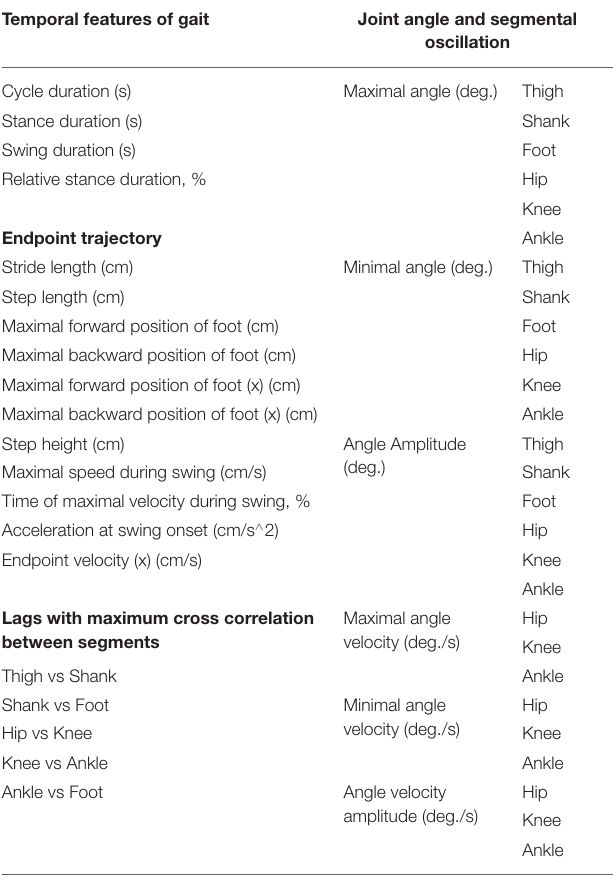
TABLE 2 | Kinematic parameters used for principal component analysis